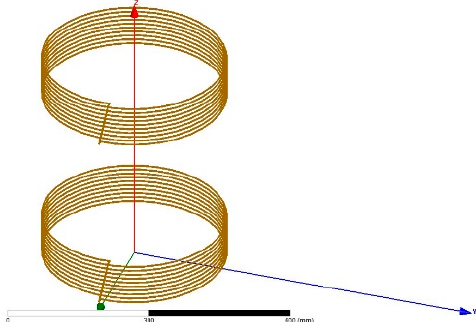
Figure 9. Simulation model of wireless power transfer system.